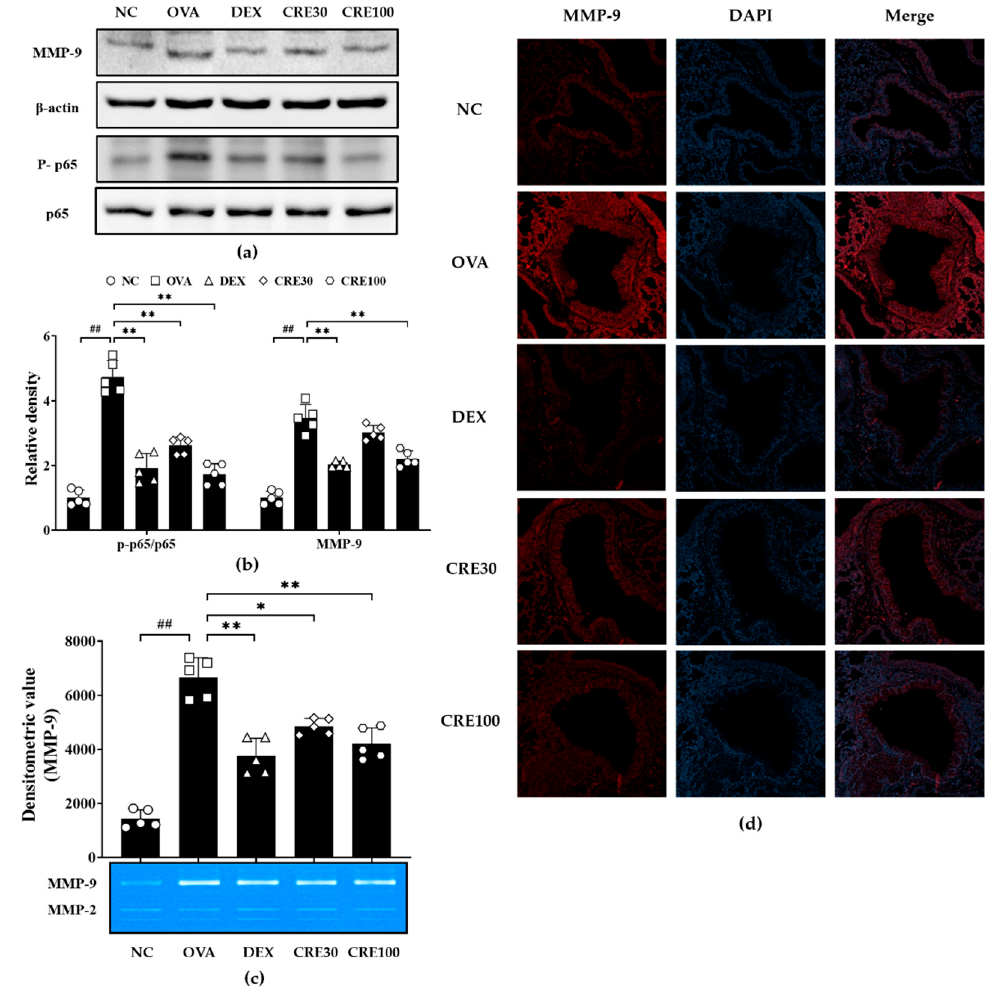
Figure 6. CRE suppressed NF- κ B phosphorylation and MMP-9 expression in animals with asthma. ( a ) The expression of NF- κ B and MMP-9, ( b ) relative density, ( c ) zymography for MMP-9, ( d ) immunofluorescence for MMP-9. NC: PBS treatment and PBS challenge; OVA: PBS treatment and OVA challenge; DEX: dexamethasone (2 mg/kg) treatment and OVA challenge; CRE30 and CRE100: CRE (30 mg/kg and 100 mg/kg, respectively) and OVA challenge. The values are shown as the mean ± SD ( n = 5). ## p < 0.01 versus NC; *, ** p < 0.05 and 0.01 versus OVA.